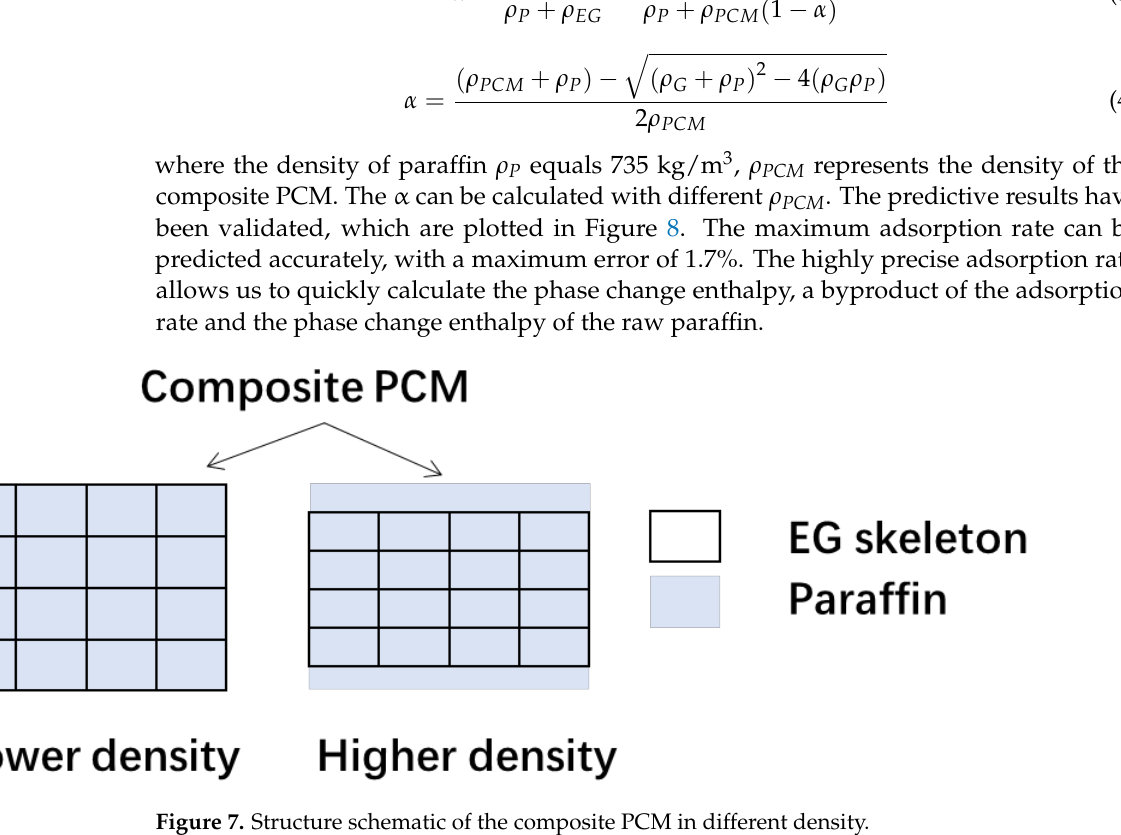
Figure 8. Validation of the model to predict the maximum adsorption rate of paraffin. Apart from the prediction of the thermal storage density, we also develop a simple model to predict the thermal conductivity, which is explained as follows: the contribution of paraffin is ignored, and only EG is considered to enhance the heat transfer. Therefore, we know the thermal conductivity of the composite PCM if the thermal conductivity of EG is calculated. As shown in Figure 9, graphite is a dense carbon material. When it is expanded to EG, voids take place between different layers of the EG skeleton. These voids lower the thermal conductivity of the graphite. We present an effectiveness ratio β to char- acterize the impact of EG on the enhancement of the thermal conductivity of graphite. β = 𝜌𝜌 𝐸𝐸𝐸𝐸 𝜌𝜌 𝐸𝐸